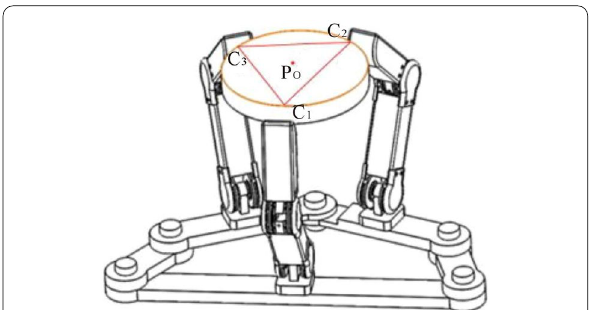
Figure 3 Center of the grasped